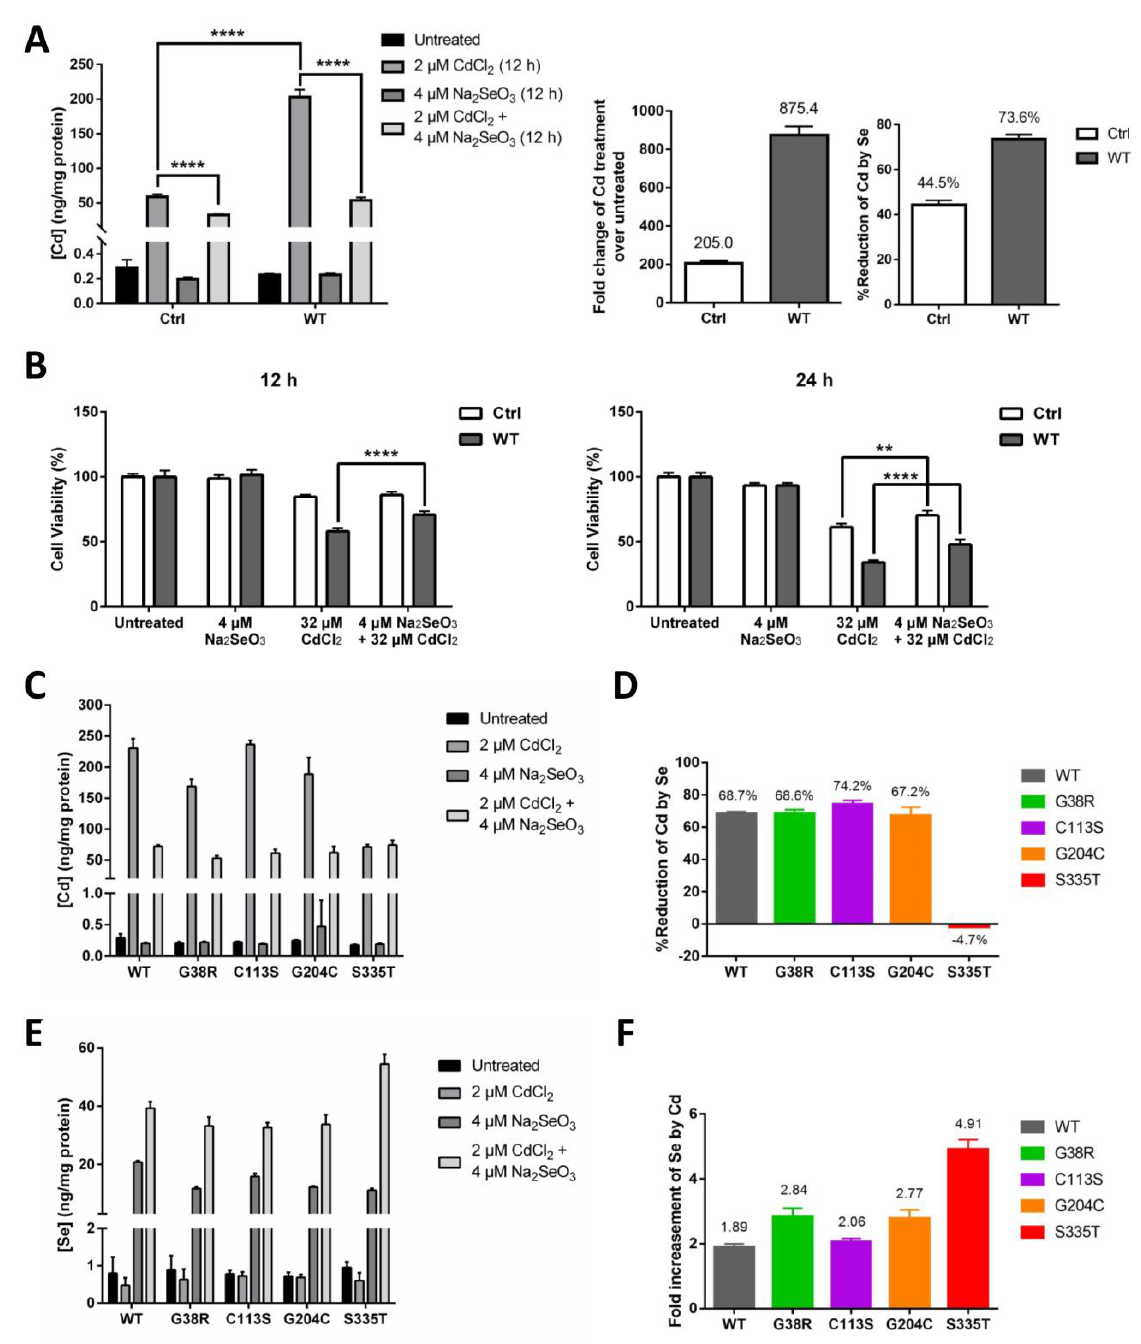
Figure 4. Se reduces Cd-induced cytotoxicity via decreasing the level of intracellular Cd transported by ZIP8. ( A , B ) The HeLa ZIP8-KO cells were transfected with a control plasmid (pcDNA3.1 empty vector) or pcDNA3.1-ZIP8-WT overexpression plasmid for 36 h, and cells were treated with various concentrations of CdCl 2 and/or Na 2 SeO 3 for 12 h. Intracellular Cd content was measured by the ICP-MS ( A ), and cell viability was determined by the NBB staining assay ( B ). ( C , E ) Intracellular Cd ( C ) or Se ( E ) concentration was determined by ICP-MS after exposed to 2 µ M CdCl 2 and/or 4 µ M Na 2 SeO 3 for 12 h in HeLa ZIP8-KO cells overexpressing ZIP8-WT or ZIP8-mutant. ( D ) Percentage reduction of intracellular Cd level between the Cd and Cd + Se treatment groups from ( C ). ( F ) Fold change of intracellular Se level between the Se and Cd + Se treatment groups from ( E ). Data in ( B ) are representative of three experiments, and the error bars represent standard deviation of six replicates. Two-way ANOVA (A, B) and one-way ANOVA ( A ) were performed, and a p -value less than 0.05 was considered to be statistically significant. ** p < 0.01, **** p <